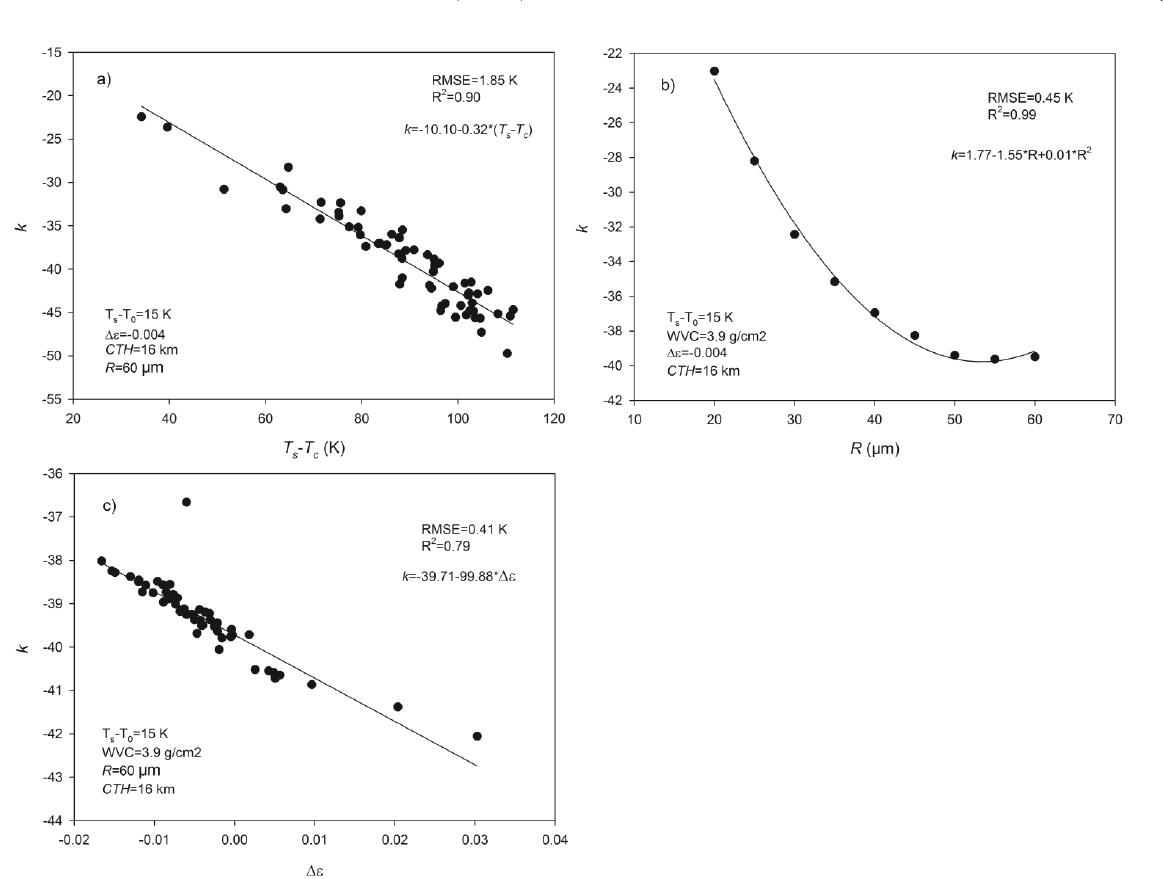
Figure 3. The relationships between slope k in Equation (3) and ( a ) the difference between LST and cirrus temperature ( T s − T c ); ( b ) the cirrus effective radius ( R ); ( c ) the difference of the split-window channel emissivities ( 